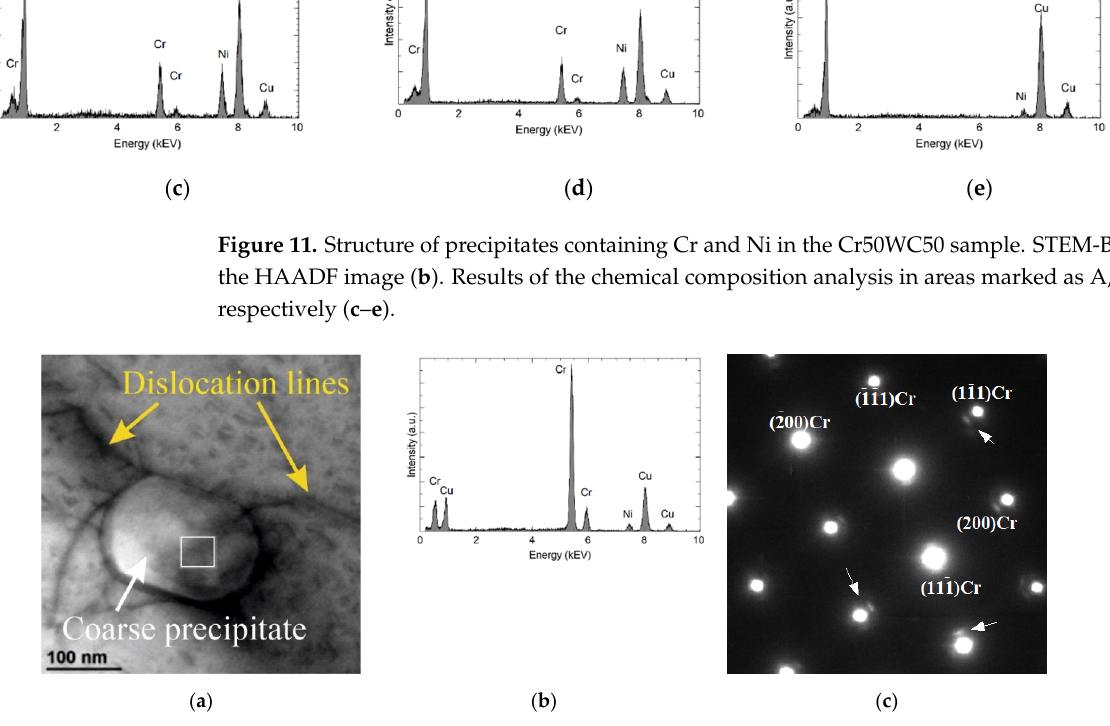
Figure 12. Structure of the precipitate containing Cr and small amount of Ni in the Cr50WC50 sample. The STEM-BF image ( a ) result of the chemical composition analysis ( b ), SAED of the fcc Cr in [011] zone axis ( c ).